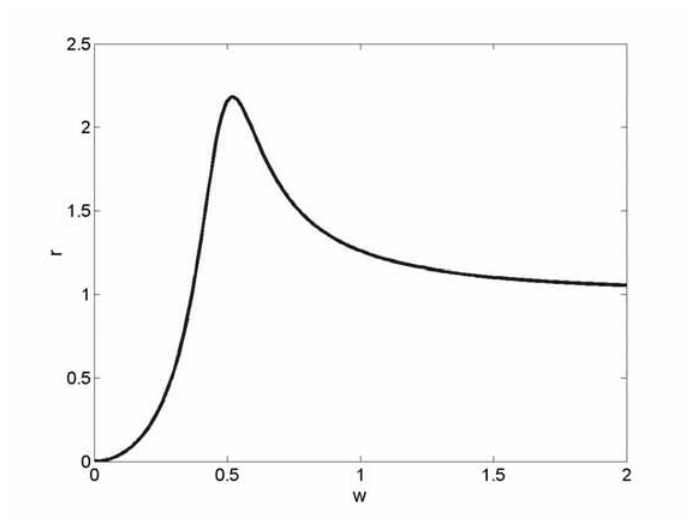
Fig. 4. Relative engine mass